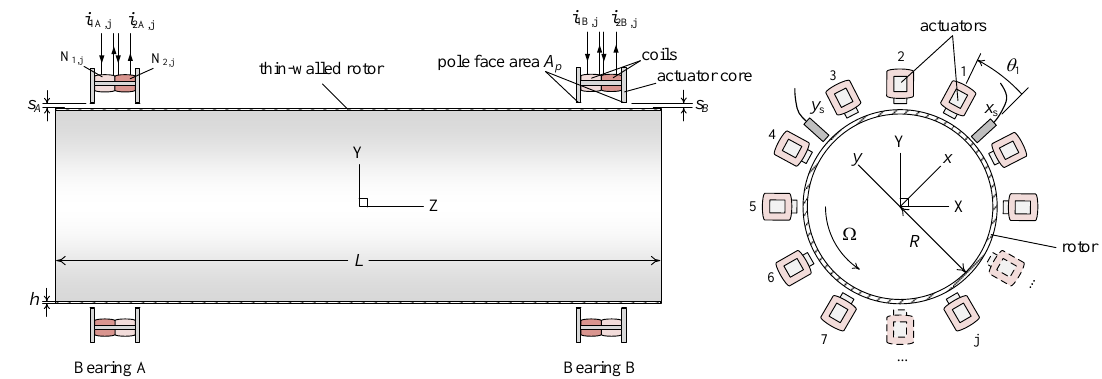
Figure 3. Thin-walled rotor with DAMB supports: Cross-section